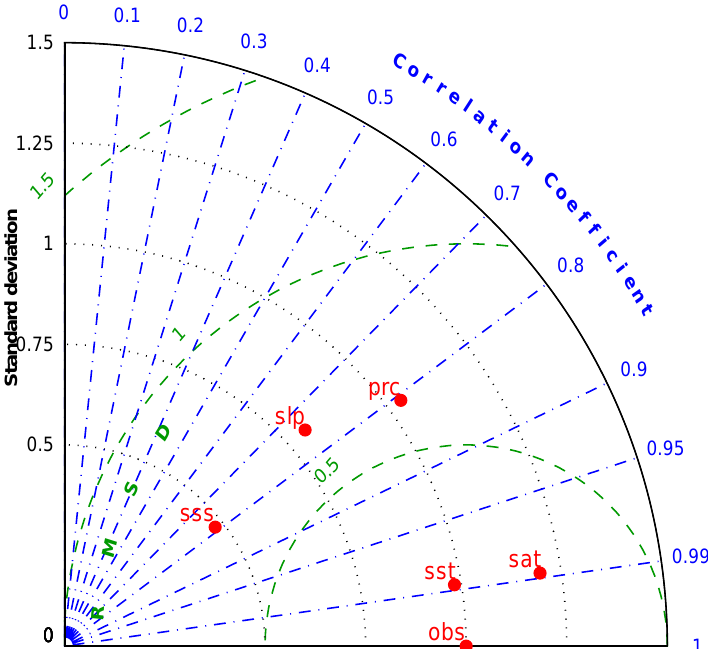
Fig. 1. Taylor diagram for annually-averaged sea surface temperature (sst), salinity (sss), surface air temperature (sat), precipitation (prc) and sea level pressure (slp) from the reference run (REF) as compared to climatology Levitus and NCEP reanalysis.